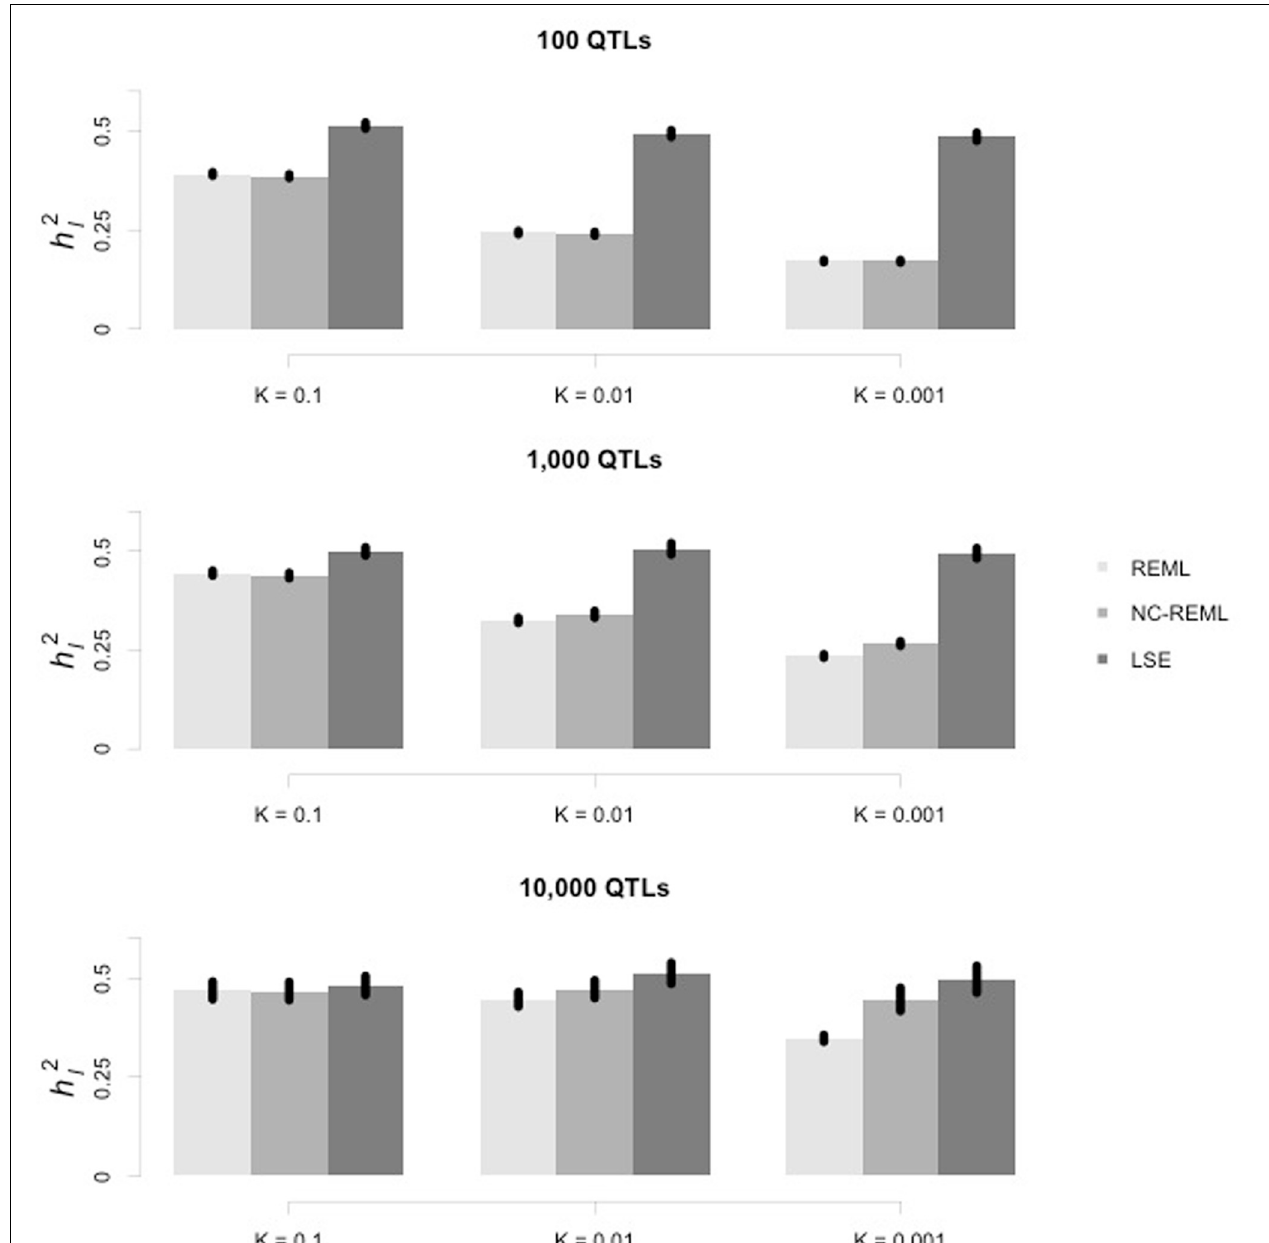
FIGURE 1 | Estimation of heritability on the liability scale using the HE regression and mixed linear model methods. In each row, from left to right, each panel represents the case-control sample simulated under the same heritability on the liability scale ( h 2 l ) but with different prevalence. In each panel, the vertical axis indicates